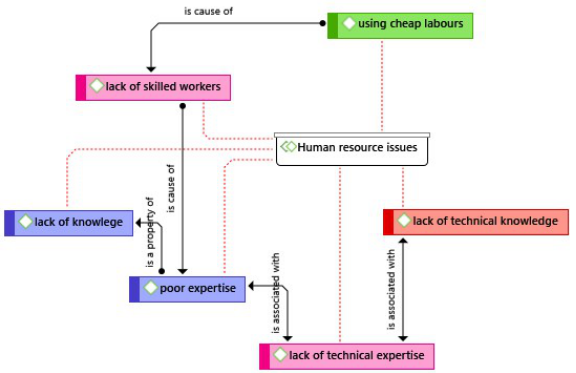
Fig. 7. Theme 4 (Human resource issues)